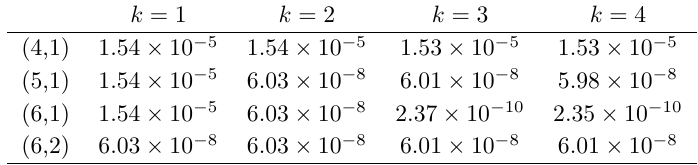
Figure 5: Multivariate t -test for sections of the (3,1)- EPMult based on Exp-Log GF(2 8 ) multiplication. Share-1 vs Share-1 shows the multivariate t -test results of all combinations of points during the first GF(2 8 ) multiplication. Share-1 vs Share-2 shows the results of the multivariate t -test for the combination of points from the first field multiplication to the second one. Share-1 vs Share-3 corresponds to the multivariate t -test analog to the previous case. Share-1 vs Other shows the results of multivariate t -test of the points during the first field multiplication combined with all the points of a section close to the end of EPMult . Table 9: Probabilities of generating undetectable faults for EPMult